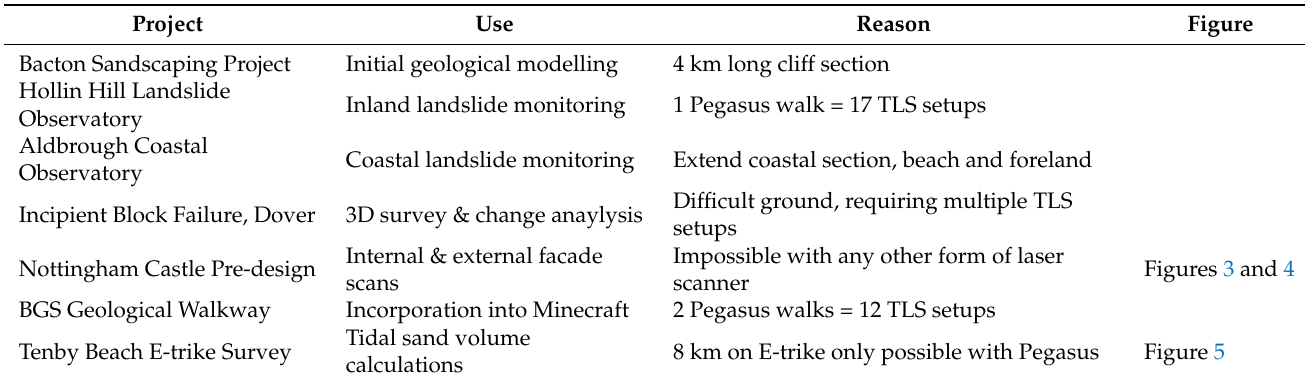
Figure 5. Pegasus Backpack mounted on an e-trike at Tenby, Wales.